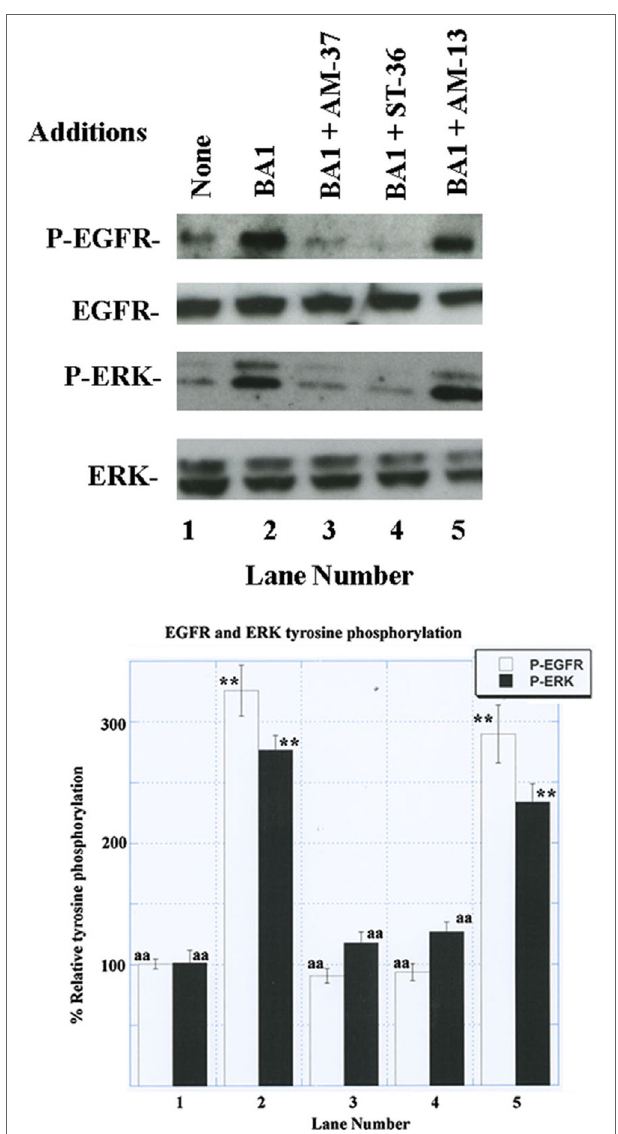
FigUre 3 | Western blot. (Top) The ability of 100 nM bombesin agonist (BA)1 to increase EGFR and ERK tyrosine phosphorylation was investigated using NCI-H1299 cells transfected with BB 2 R in the presence of 10 µM AM-37, 10 µM ST-36, and 10 µM AM-13. (Bottom) BA1 or BA1 plus AM-13 increased significantly EGFR and ERK tyrosine phosphorylation relative to the control, whereas total ERK and EGFR were unaltered; p < 0.01; ** by ANOVA. The control, BA1 + AM-37, and BA1 + ST-36 were significantly reduced relative to BA1; p < 0.01, aa by ANOVA. The experiment is representative of three